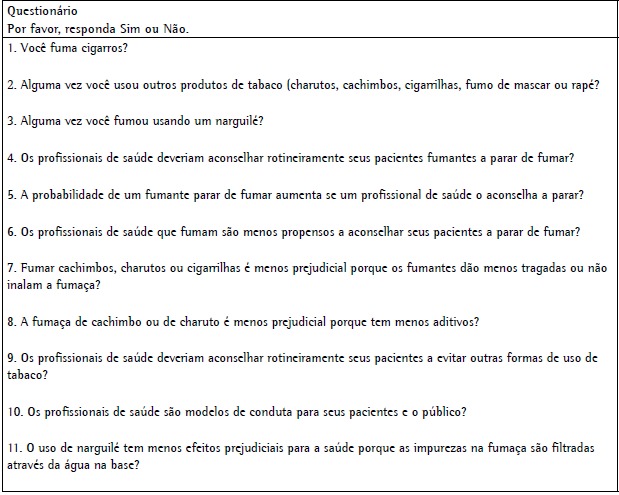
Questionário utilizado no estudo.